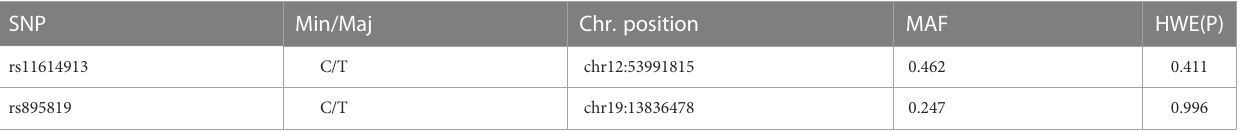
TABLE 2 SNPs information and HWE test in the